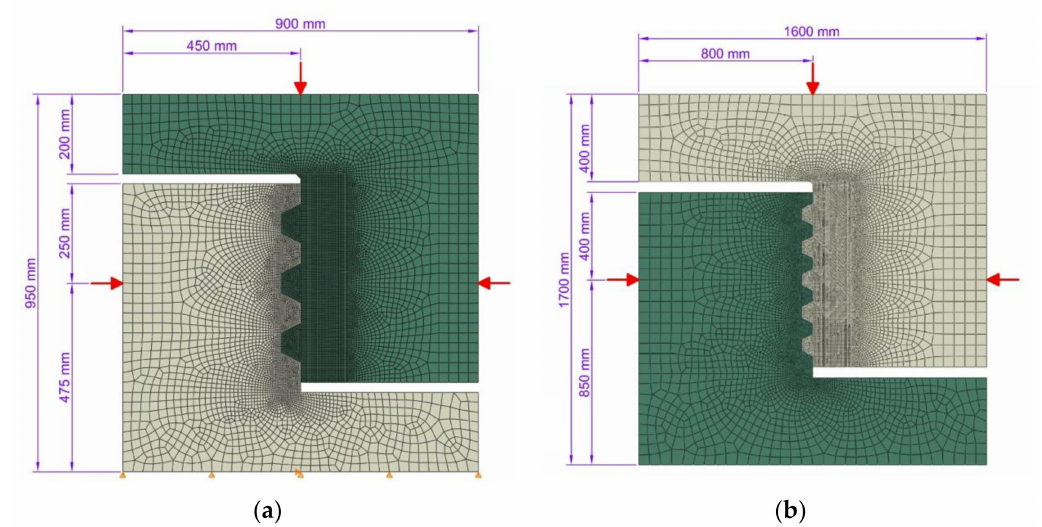
Figure 3. Scheme of the dry joints: ( a ) N k = 3 configuration; ( b ) N k = 5 configuration